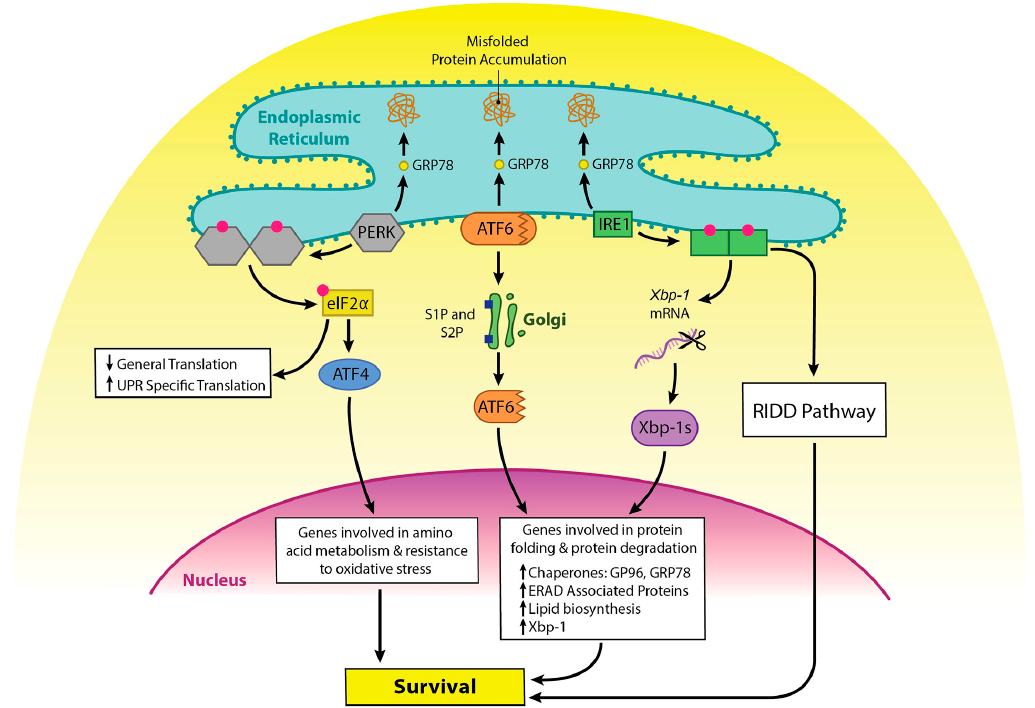
Figure 1. The role of unfolded protein response (UPR) in cell survival upon induction of ER stress. GRP78 is normally associated with PERK, IRE1, and ATF6. GRP78 disassociates from these molecules